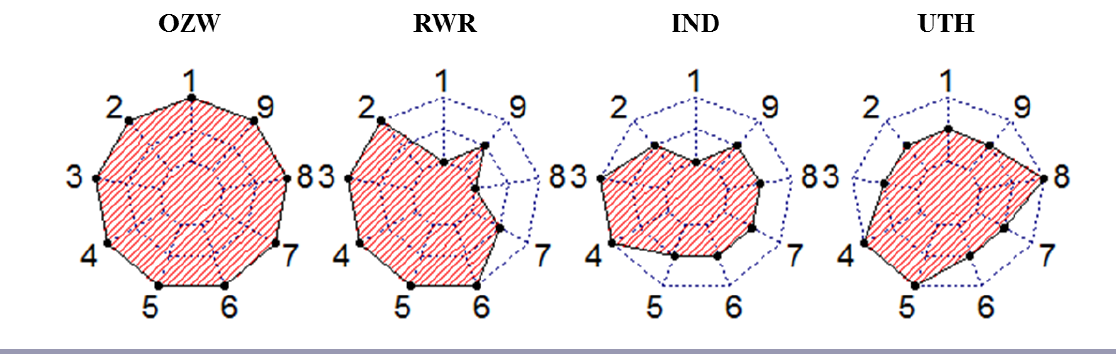
Fig. 4 . Contributions of case studies to the indicators specified for each research challenge. The inner/ middle/outer ring symbolizes that no/one/two indicators were addressed. Numbers refer to the research challenges: (1) combining qualitative and quantitative analysis, (2) engaging stakeholders, (3) reflecting functional complexity and multiple stresses, (4) integrating across themes and issues, (5) accounting for volition, (6) recognizing a wide range of outlooks, (7) spanning spatial scales, (8) accounting for temporal inertia and urgency, and (9) reflecting uncertainties, here related to integrating surprises and thresholds. OZW = Oum Zessar watershed, RWR = Rwenzori region, IND = Inner Niger Delta, UTH = upper Thukela / uThukela